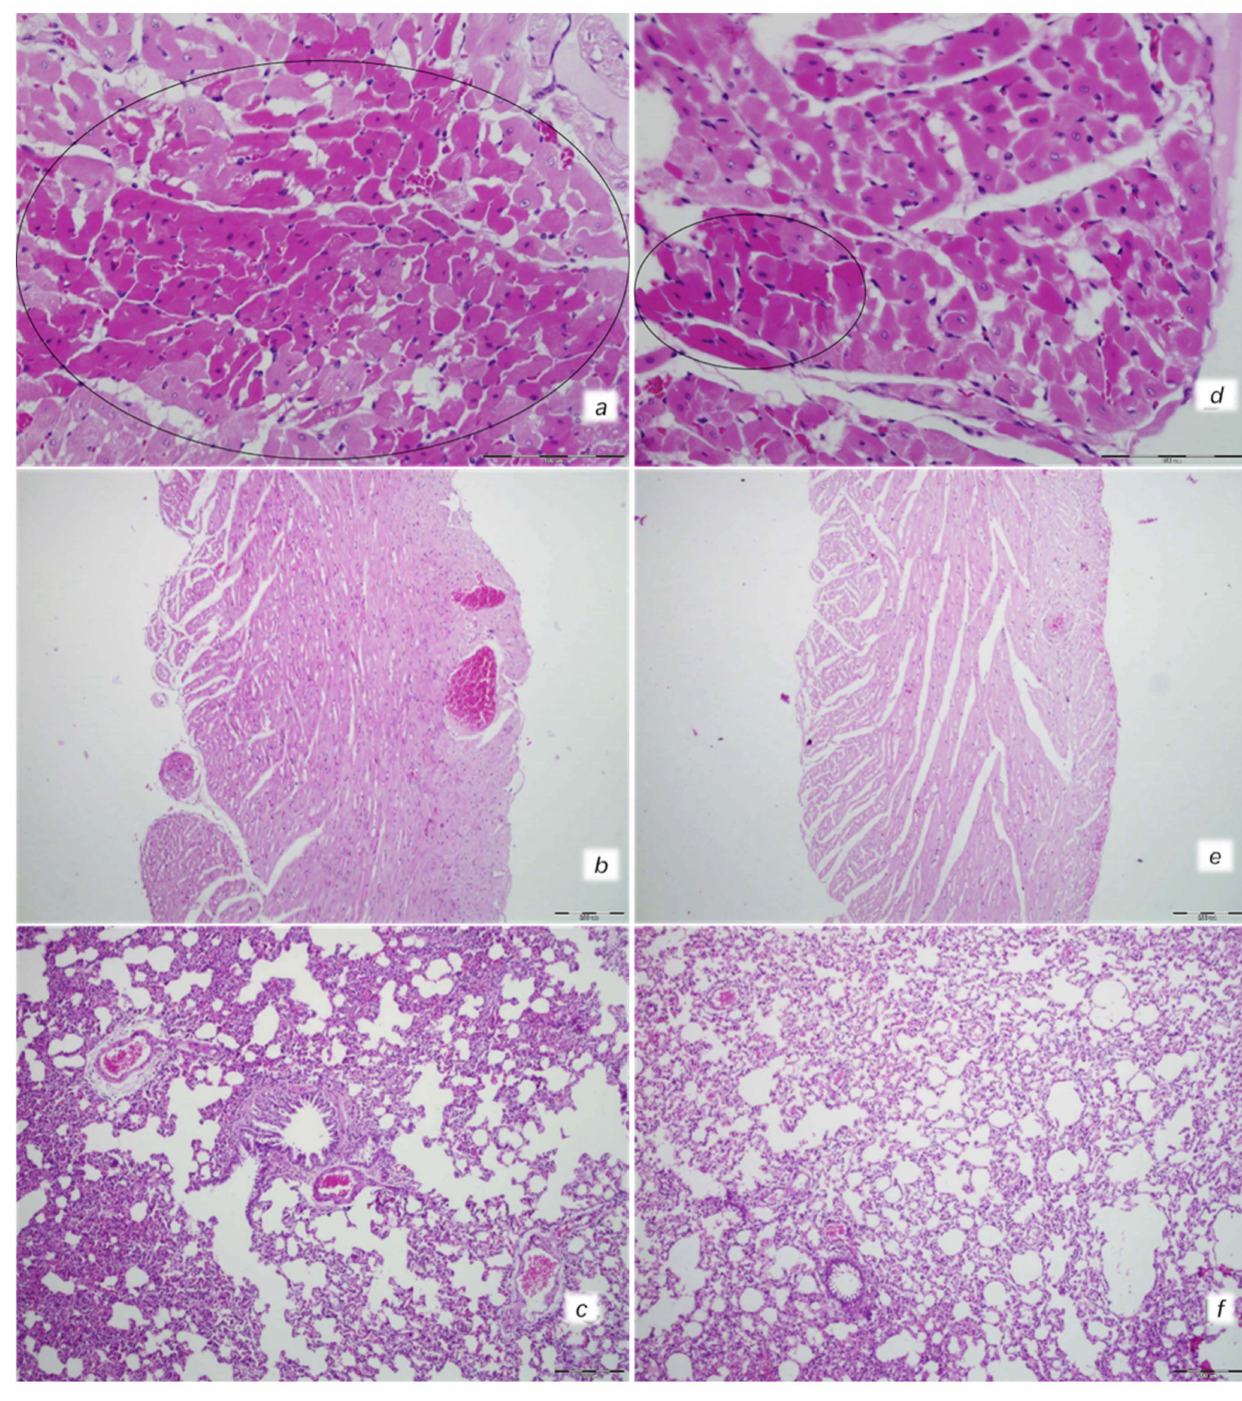
Figure 4. Heart and lung tissue damage. Isoprenaline 75 mg/kg at 30 min after challenge. Control rats ( a , b ). Myocardial congestion and confluent areas of subendocardial ischemic myocytes in the control rats (circle). Control rats ( c ). Marked congestion of the lung parenchyma in the control rats. BPC 157-treated rats ( d , e ). Mild myocardial congestion and only a small area of subendocardial ischemic myocytes (circle) in the BPC 157-treated rats ( f ). No changes in lung tissue in the BPC 157-treated rats. (HE staining; ( a , d ) magnification 400 × ; scale bar 100 µ m; ( b , c , e , f ) magnification 100 × ; scale bar 200 µ